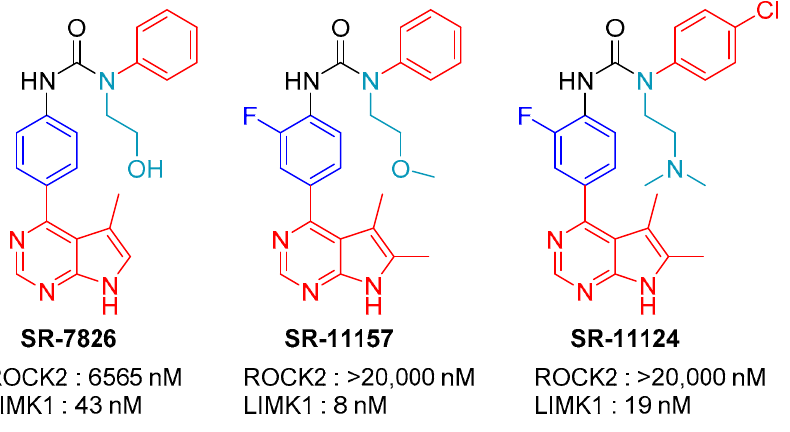
Figure 8. Optimized LIMK1 inhibitors.